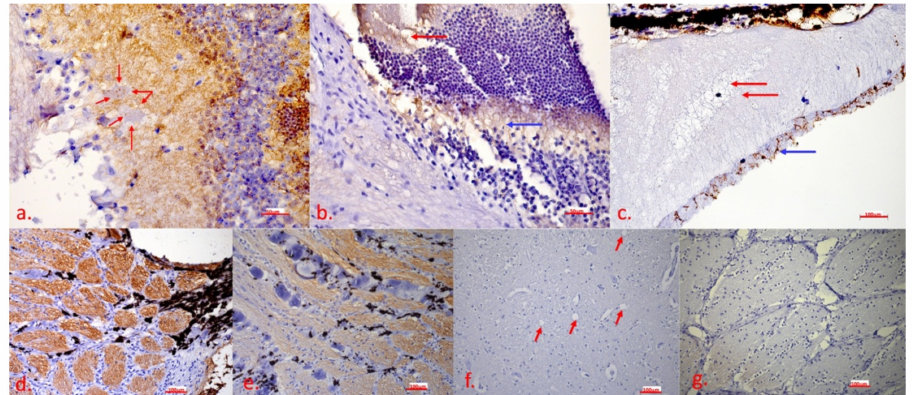
Figure 6. IHC detection of caspase 3 shows the presence of apoptosis in the eye bulb and the brain: ( a ) retina—strong presence of the brown chromogen in the inner plexiform layer, presence of the brown chromogen in the ganglion cells (red arrows); ( b ) optic disc—presence of the brown chromogen in the cone and rod layer (red arrow) and the outer plexiform layer (blue arrow); ( c ) subchoroidal layer/retina—oedema (red arrow) between the pigment epithelium and the cone and rod layer, presence of the brown chromogen in the cone and rod layer (blue arrow); ( d ) optic disc—strong presence of the brown chromogen in nerve fibres; ( e ) optic disc—calcifications between nerve fibres; ( f ) brain—no apoptosis signalling, vacuoles are marked with the red arrow; ( g ) optic disc—negative control. In Figure 6a,f, the scale bar corresponds to 50 µ m (40 × magnification), in Figure 6b,c,d,e,g, the scale bar corresponds to 100 µ m (20 × magnification). IHC to detect caspase 3, DAB chromogen, counterstain with Mayer’s